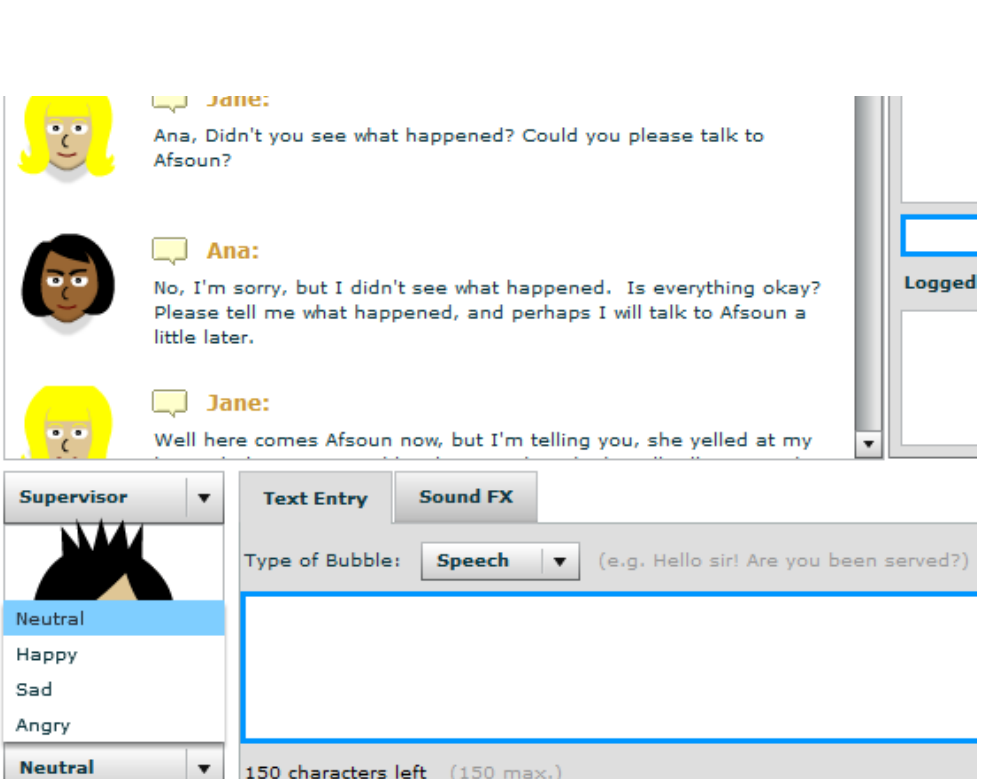
Figure 3 . Screenshot of the Lake Devo Script Building tool.